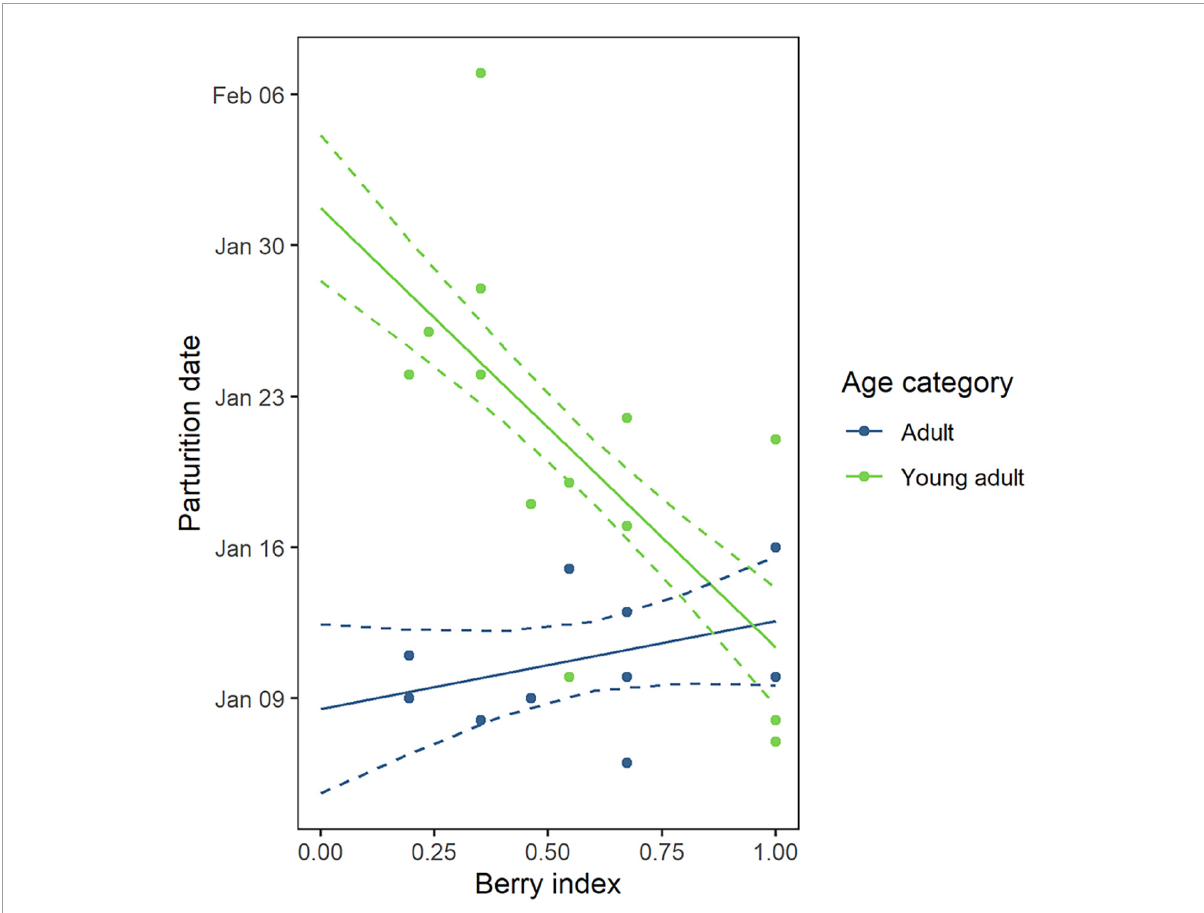
FIGURE4 Predicted parturition date for female Scandinavian brown bears ( N = 24) from the southern study area along the gradient of bilberry abundance in late summer. Estimates (solid lines) and observations (filled dots) during 2012–2018 are shown for young adults (green, N = 13) and adults (blue, N = 11). Dashed lines represent the 95% confidence